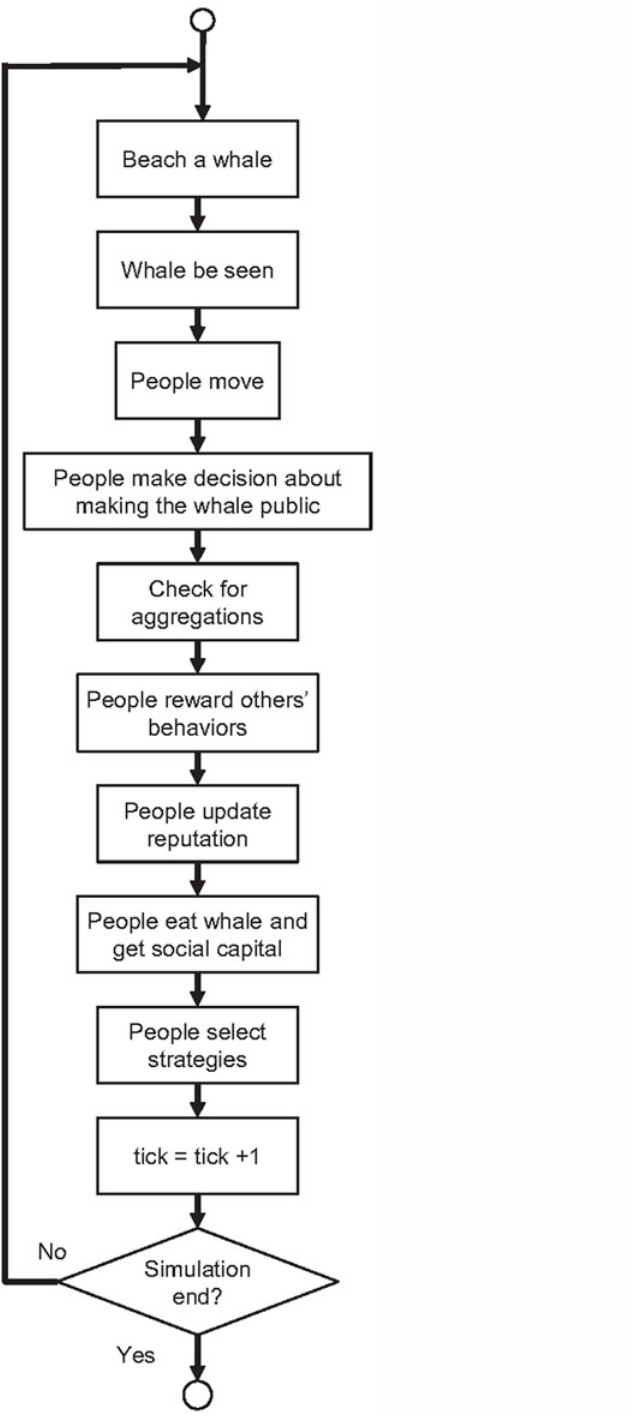
Fig 2. Diagram of the implementation schedule.